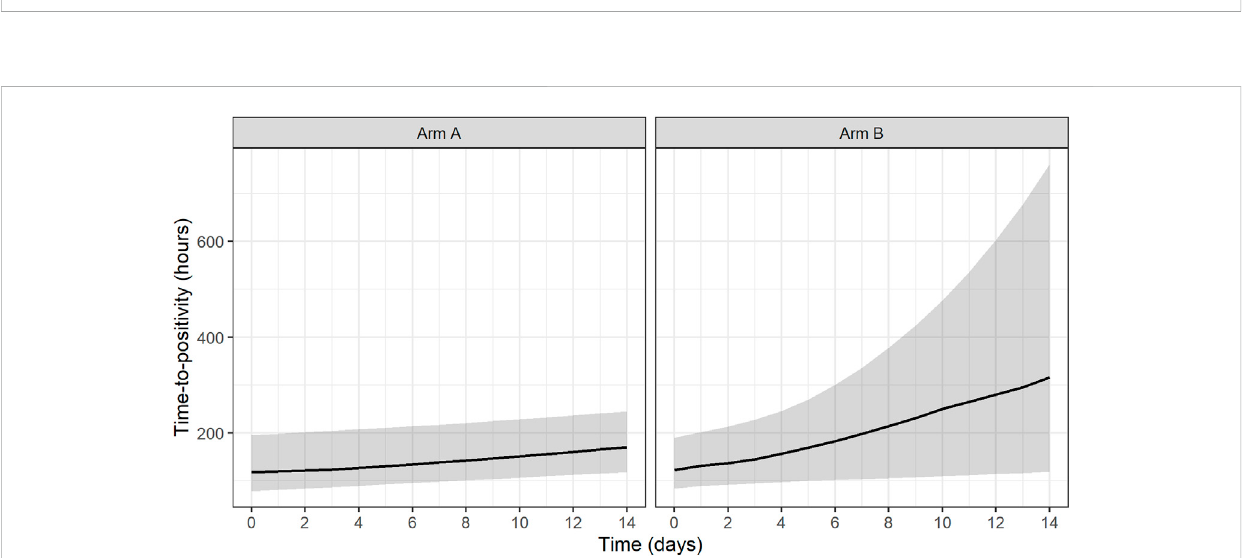
FIGURE 6 Prediction of individual time-to-positivity (TTP) over time based on Bayes estimates of the fi nal model. Lines represent the predicted median with a shaded area corresponding to the 95% prediction interval. Arm A resembling meropenem in 2 g meropenem thrice daily with 500 mg amoxicillin and 125 mg clavulanate thrice daily on days 1 – 14 (De Jager et al., 2022). Arm B resembling meropenem in 6 g meropenem once daily with 2 × 1000 mg amoxicillin and 62.5 mg clavulanate plus 400 mg bedaquiline once daily on days 1 – 14 (unpublished data, ClinicalTrials.gov Identi fi er: